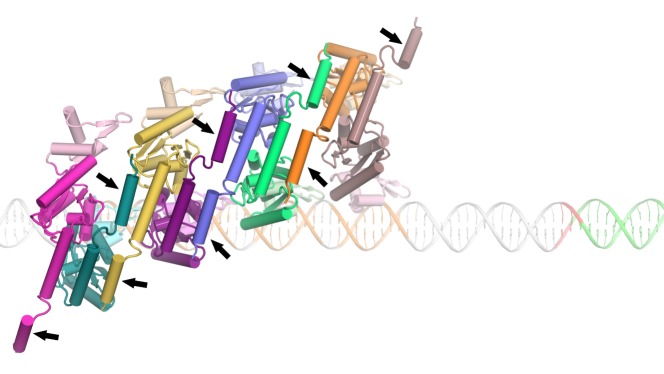
Illustration of a potential helix-swap mechanism by which the helix E region could remodel to promote cooperative binding onto the LE.The C-terminal segments (arrows) of the E helices are swapped with neighboring dimers. The DNA in this model has an average helical twist of 34.2° corresponding to 10.52 bp/turn.